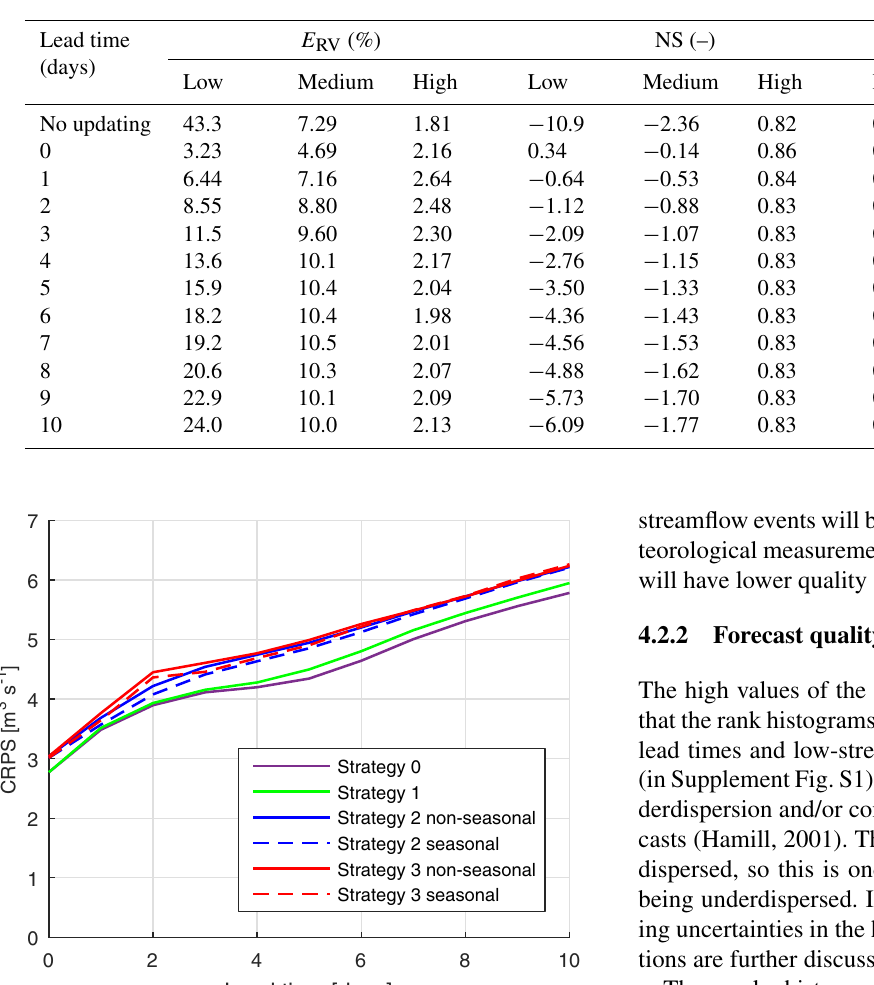
Table 5. Performance over the evaluation period 2008–2013, for low-, medium- and high-streamflow simulations (observed meteorological input forecasts). The initial states are updated at the lead time of 0 days.